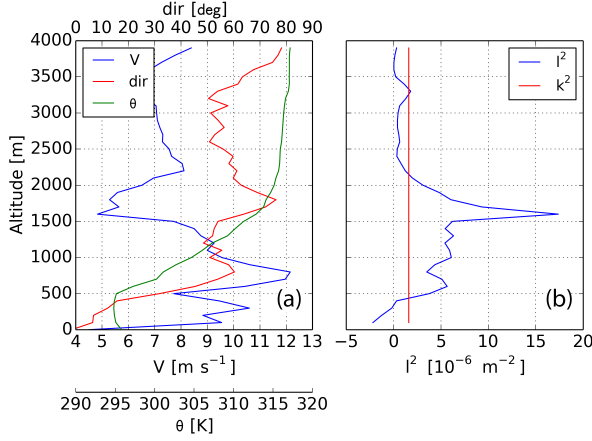
Figure 6. (a) Horizontal wind speed (blue), wind direction (red) and potential temperature (green) measured by the Falcon in situ sensors during take-off (10:06 to 10:14LT). (b) Derived Scorer parameter (blue) and approximate wave number corresponding to the observed waves (red).